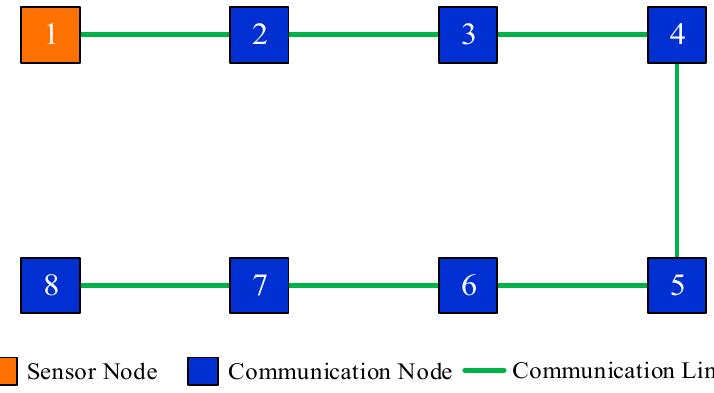
Figure 8. A sensor network with chain topology.